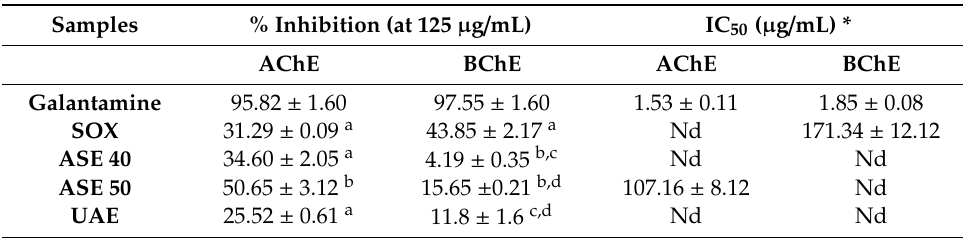
Table 3. Results of inhibitory activity against acetylcholinesterase (AChE) and butyrylcholinesterase (BChE)